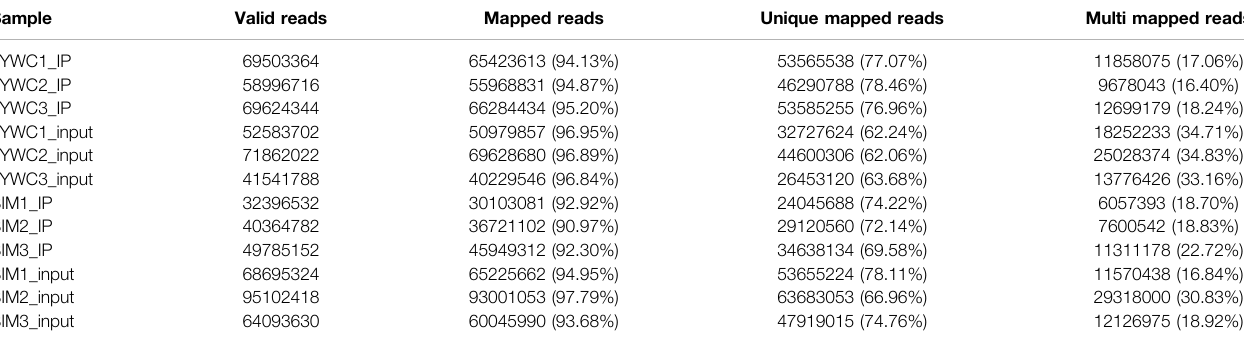
TABLE 3 | Summary of reads mapped to the cattle reference genome. Sample Valid reads Mapped reads Unique mapped reads Multi mapped